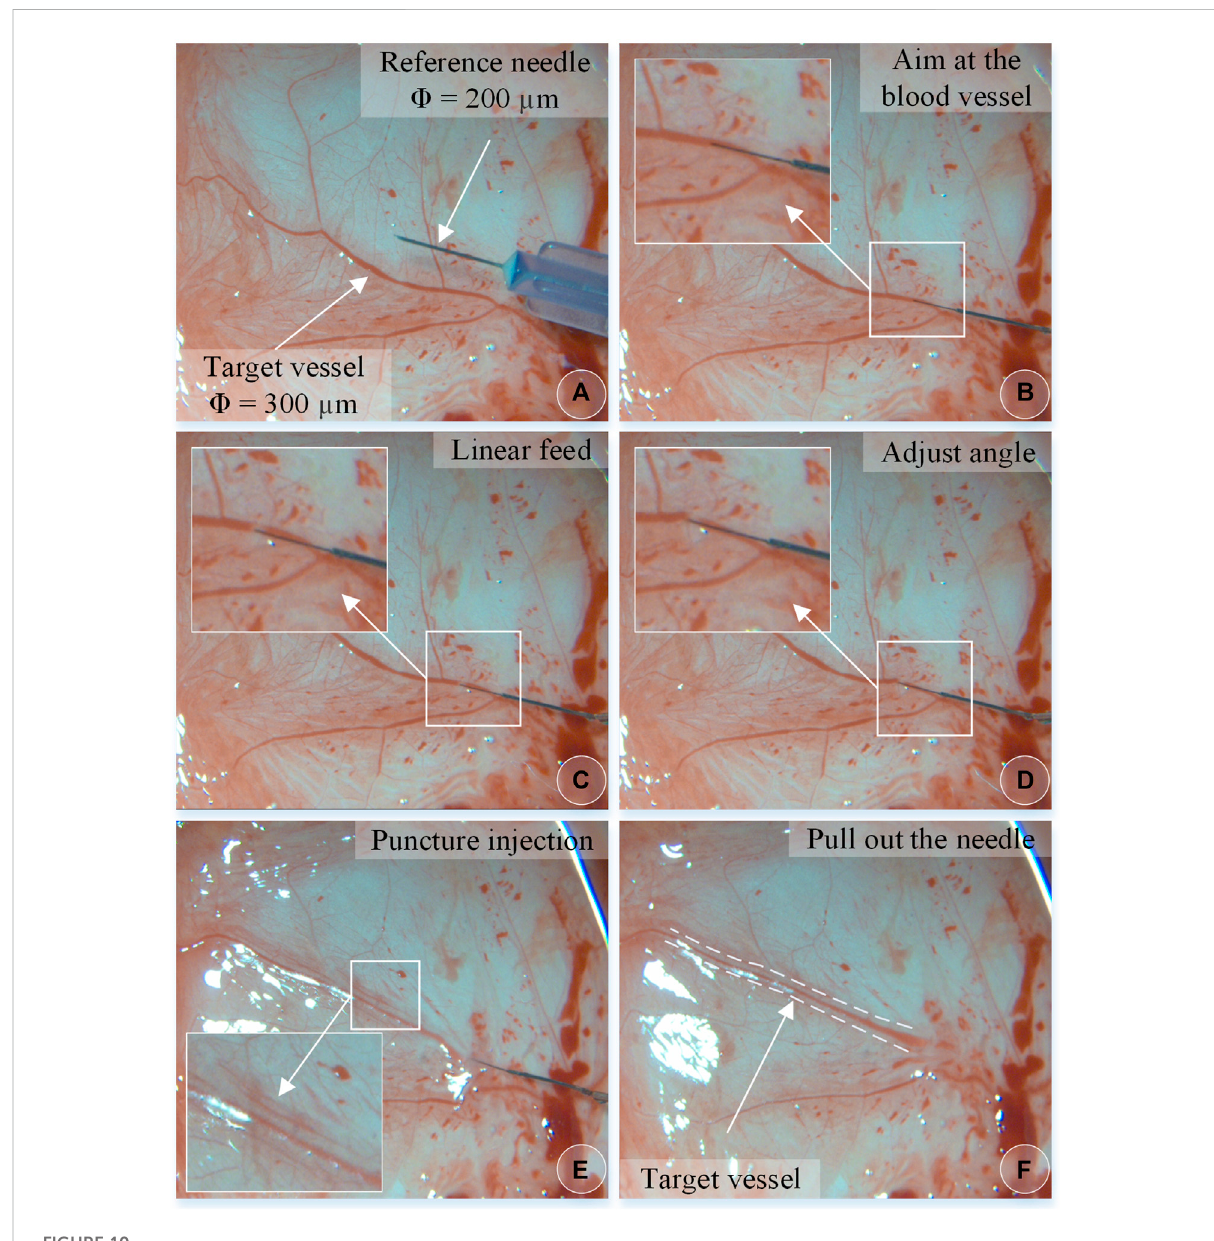
FIGURE 10 The vascular puncture, injection, and withdraw process of CAM by microscopic images (A – F)